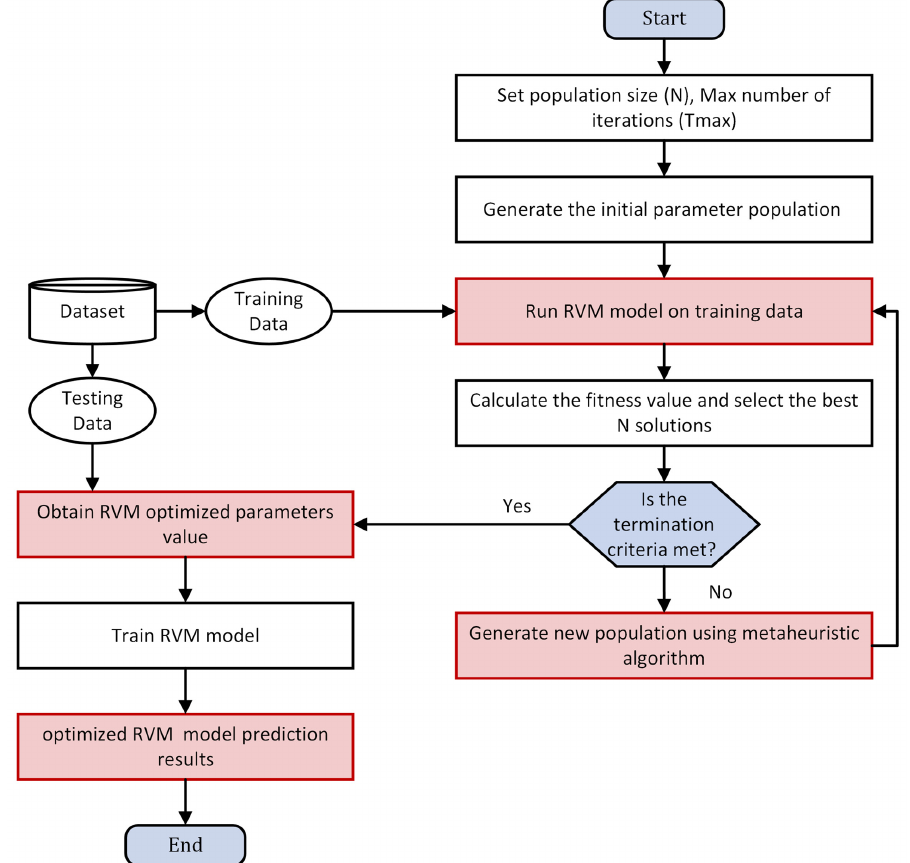
Figure 4. The main steps of optimized RVM.